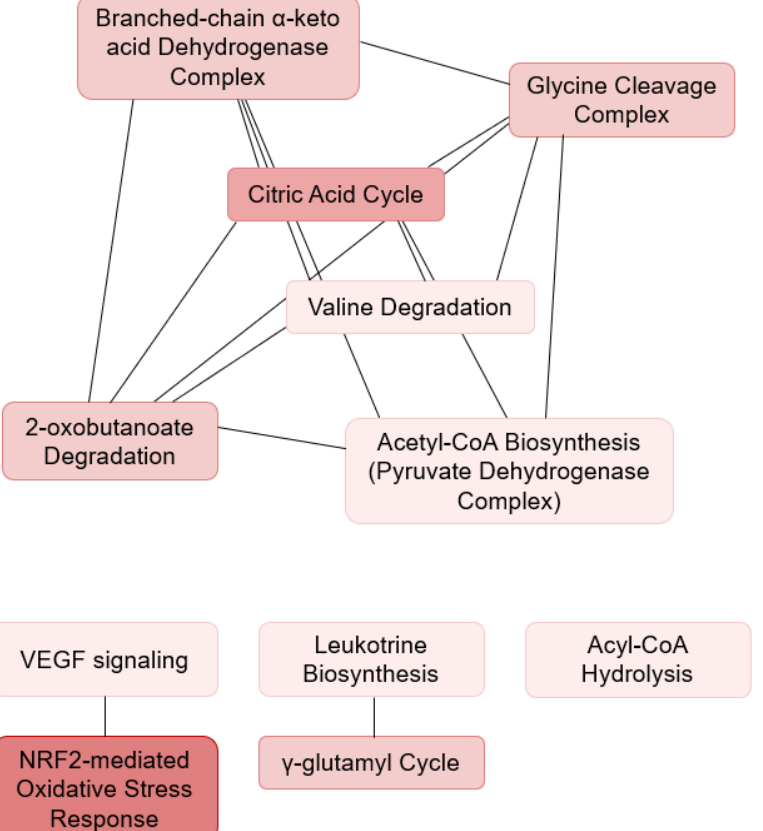
Figure 3. Ingenuity pathway analysis in MPN-AITL and R-AITL patients. Significantly disturbed pathways between the MPN-AITL and R-AITL specimens showing shared proteins between the pathways. Abbreviations: VEGF , Vascular Endothelial Growth Factor; NFR2 , nuclear factor erythroid 2-like 2.